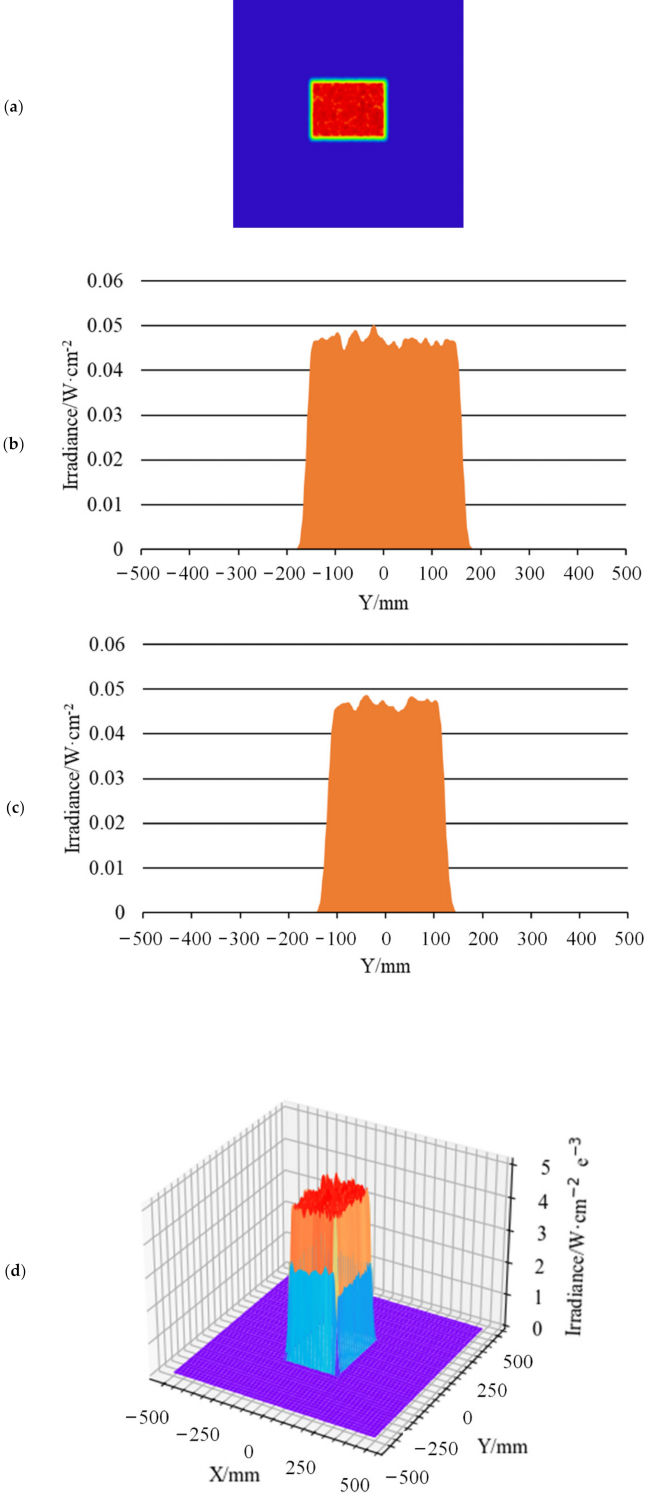
Figure 20. Laser spot and energy distribution at distance of 20 m: ( a ) Light spot; ( b ) Energy distri- bution in the horizontal direction; ( c ) Energy distribution in the vertical direction; ( d ) 3D energy